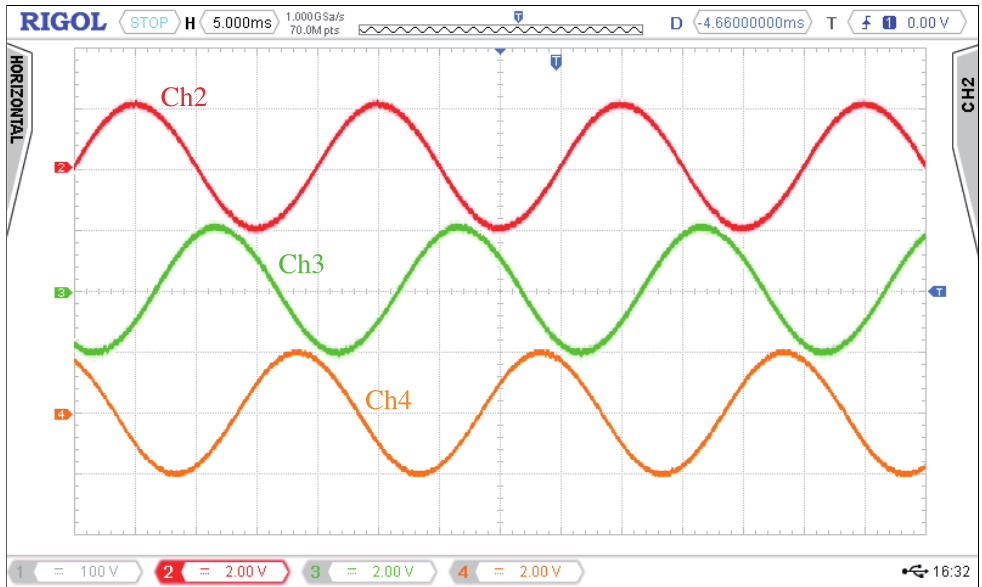
Figure 12. Grid currents at nominal 10 kVA with the IPCC control and CE. Ch2: phase R (20 A/div); Ch3: phase S (20 A/div); Ch4: phase T (20 A/div).